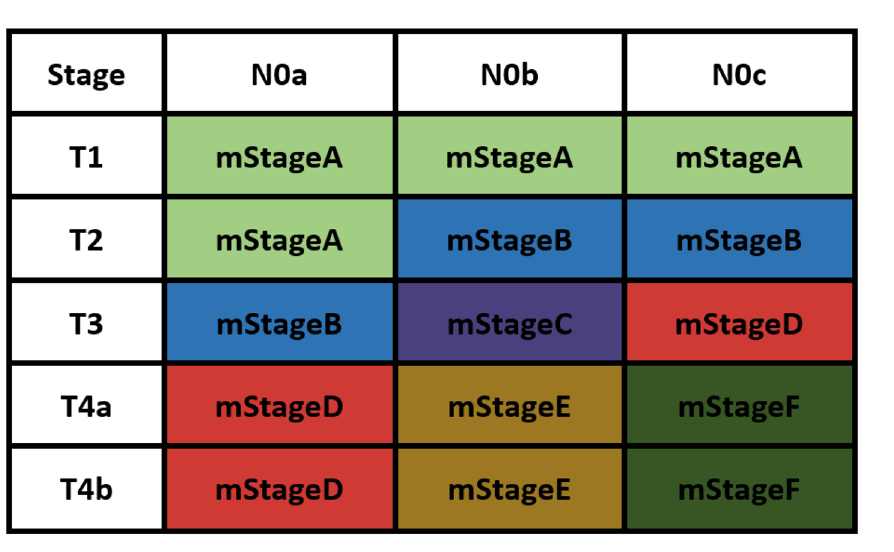
Figure 3. Modified TNM staging